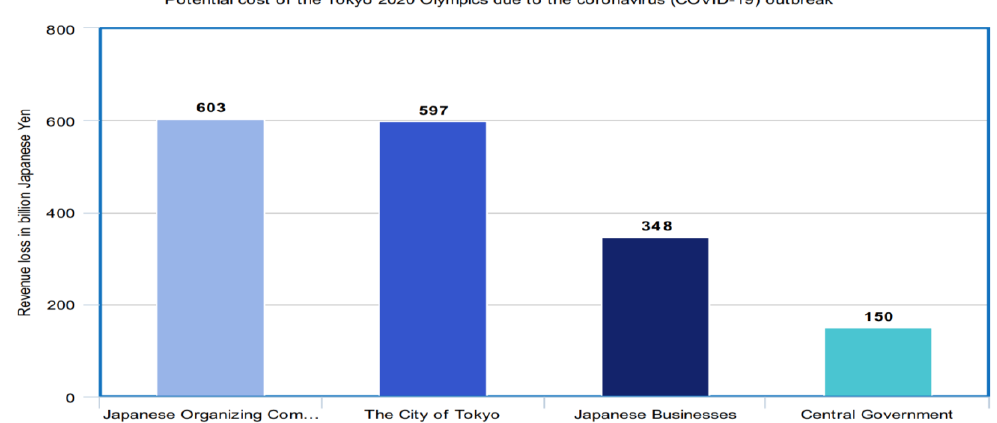
Figure 14. Potential cost of Tokyo 2020 Olympics due to the COVID-19 outbreak.